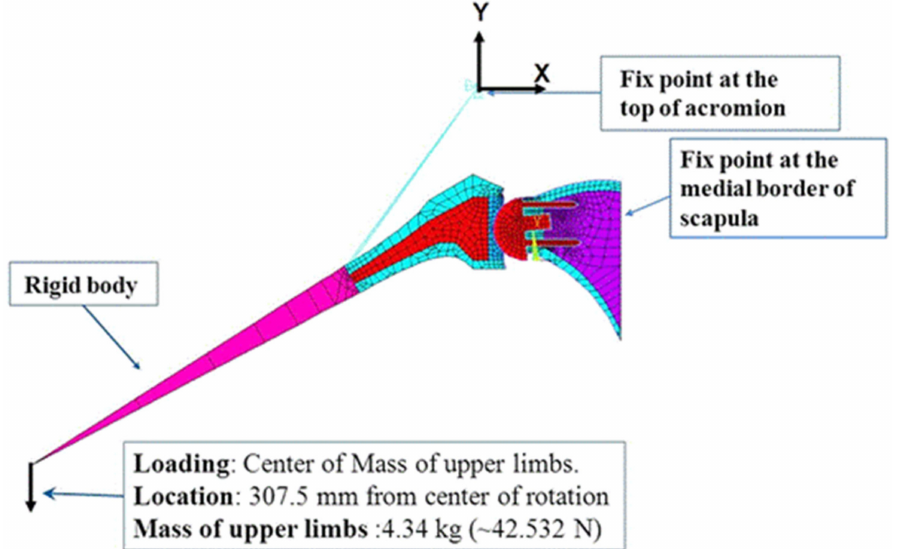
Figure 3. A 2D finite element model of the shoulder with a reverse prosthesis used to simulate internal stresses associated with the glenoid component during joint loading